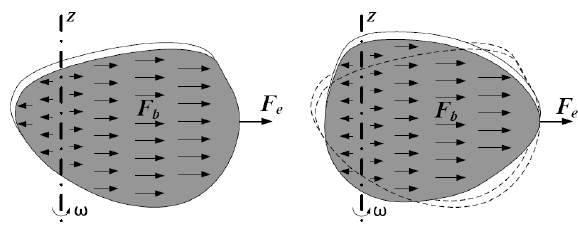
Fig.1. Schematic examples of centrifugal